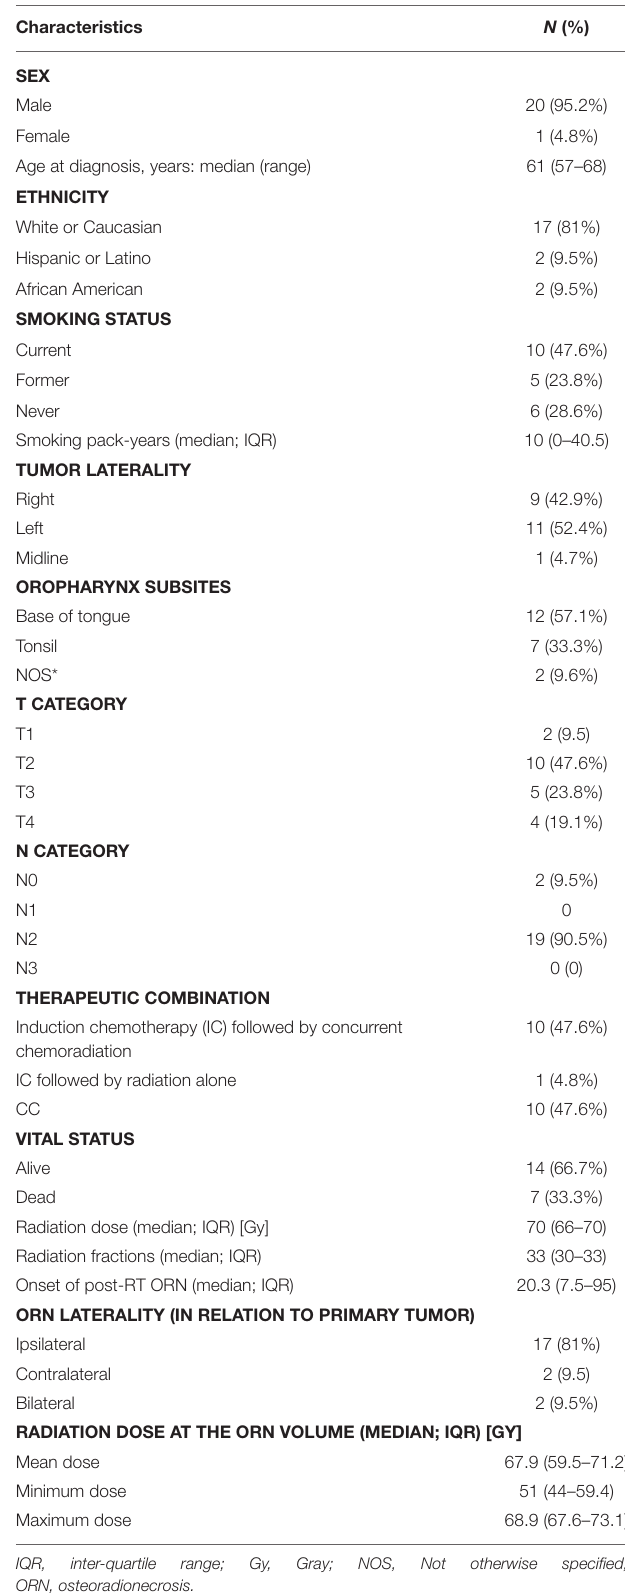
TABLE 1 | Patients, disease, and treatment characteristics.